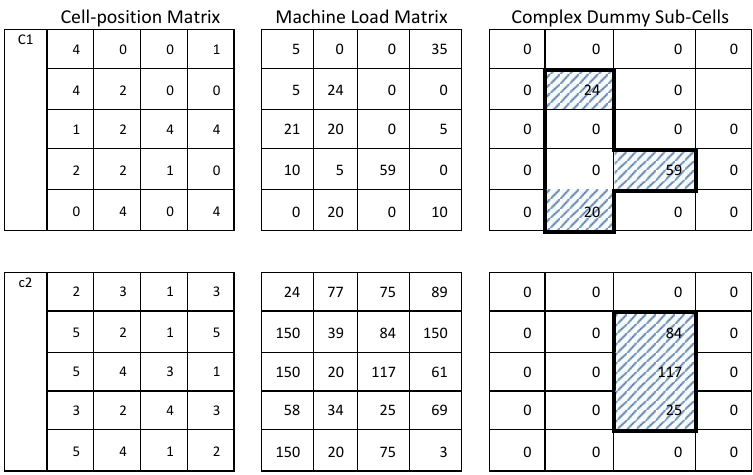
Fig. 24. Results of Equation for first period in final solution of experiment number 𝑪𝑪𝑪𝑪𝑪𝑪𝑪𝑪 𝒑𝒑 , 𝒒𝒒